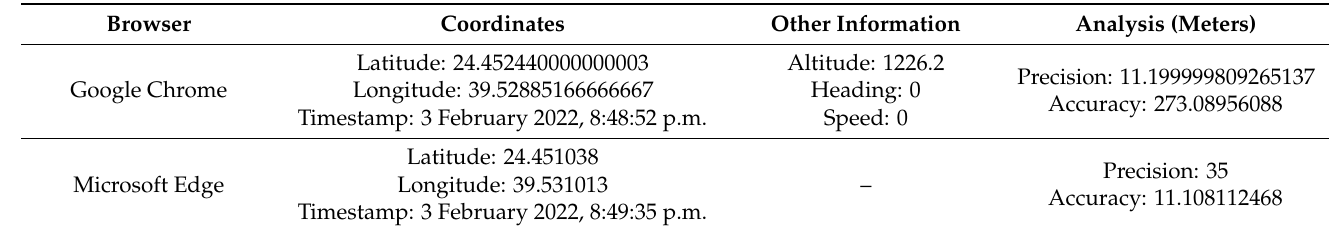
Table 10. Result and Comparison of W3C Geolocation API in HUAWEI by a wireless network